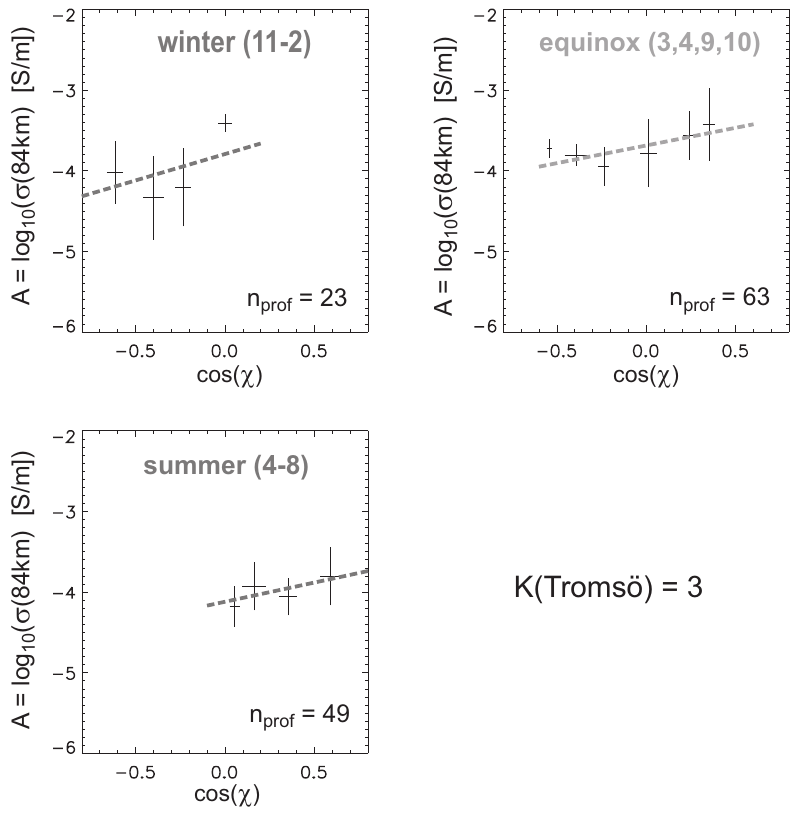
Fig. 6. Dependence of the constant A on solar zenith angle and season for ge- omagnetic conditions K =